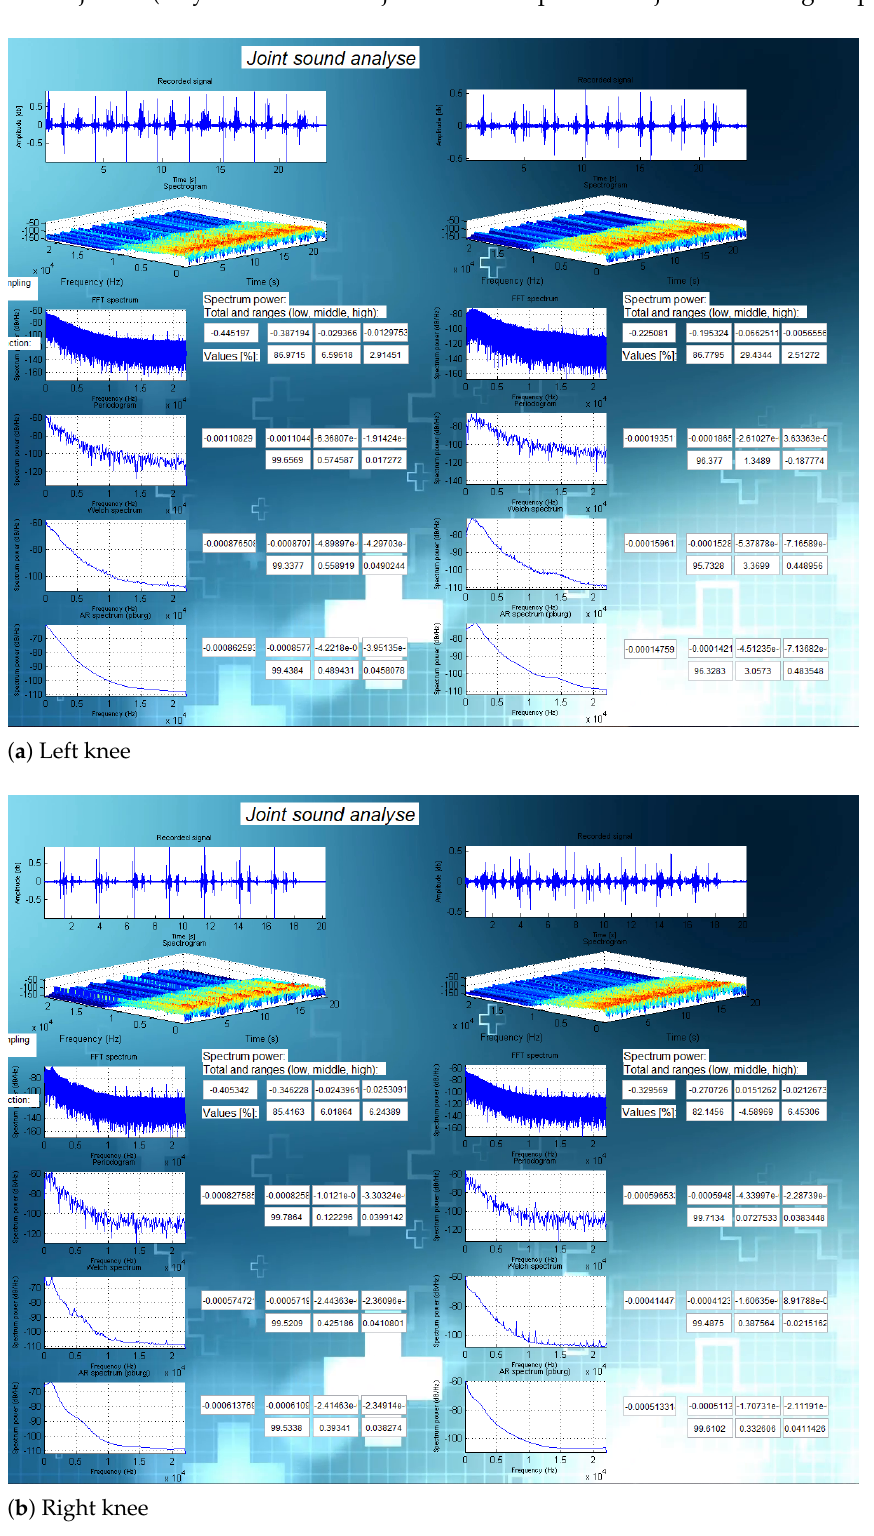
Figure 8. Analysis for a young and healthy person (subject